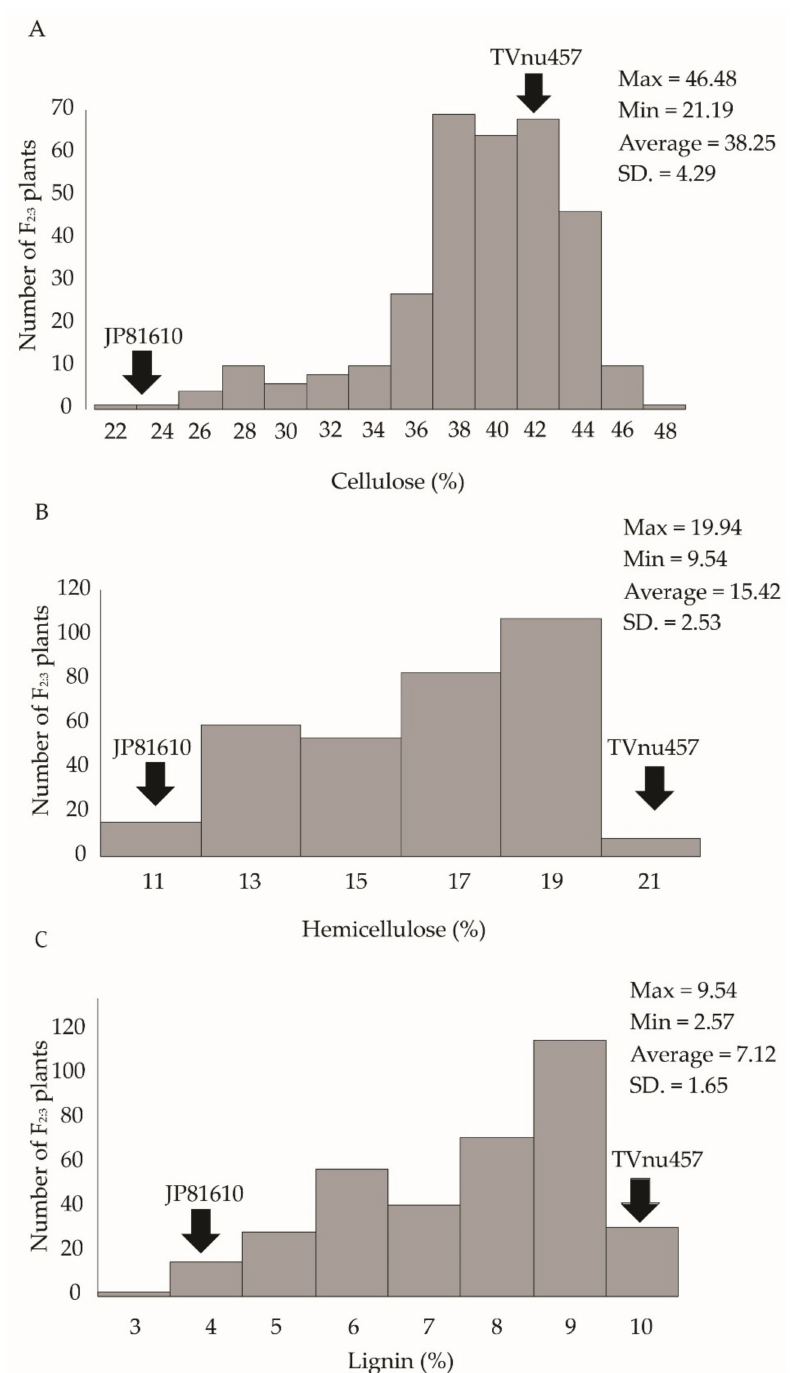
Figure 2. Frequency distribution of cellulose ( A ), hemicellulose ( B ) and lignin ( C ) content of dry pod in F 2:3 population F2C of the cross JP81610 × TVnu-457. The fibers were determined by the NIR microscopy